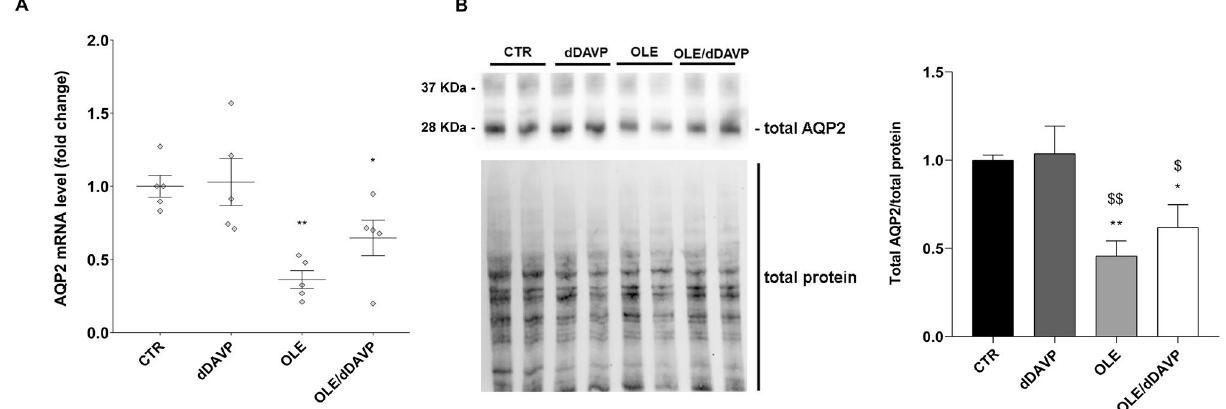
Figure 8. Effects of OLE on AQP2 mRNA and total protein expression in rat kidneys. ( A ) For the analysis of AQP2 mRNA levels, RNA was extracted from control and treated rat kidneys as described in methods. Data are shown as single values in a scatter plot reporting means ± S.E.M (*p < 0.05 or **p < 0.01 vs CTR). ( B ) Densitometric analysis of total AQP2 bands normalized to the total protein content is reported in the histogram. Data are expressed as means ± S.E.M (*p < 0.05 or **p < 0.01 vs CTR; $p < 0.05 or $$p < 0.01 vs